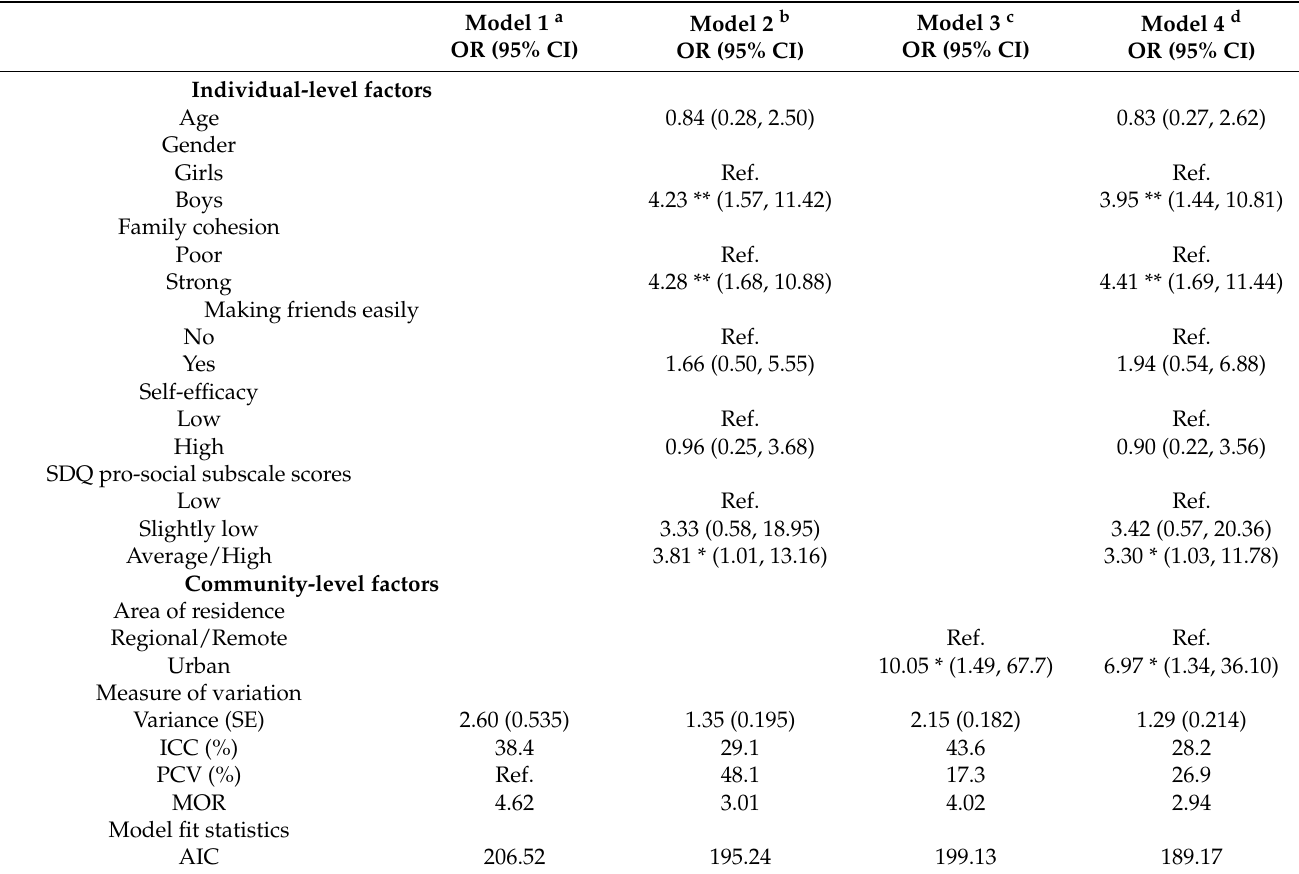
Table 5. Protective factors against